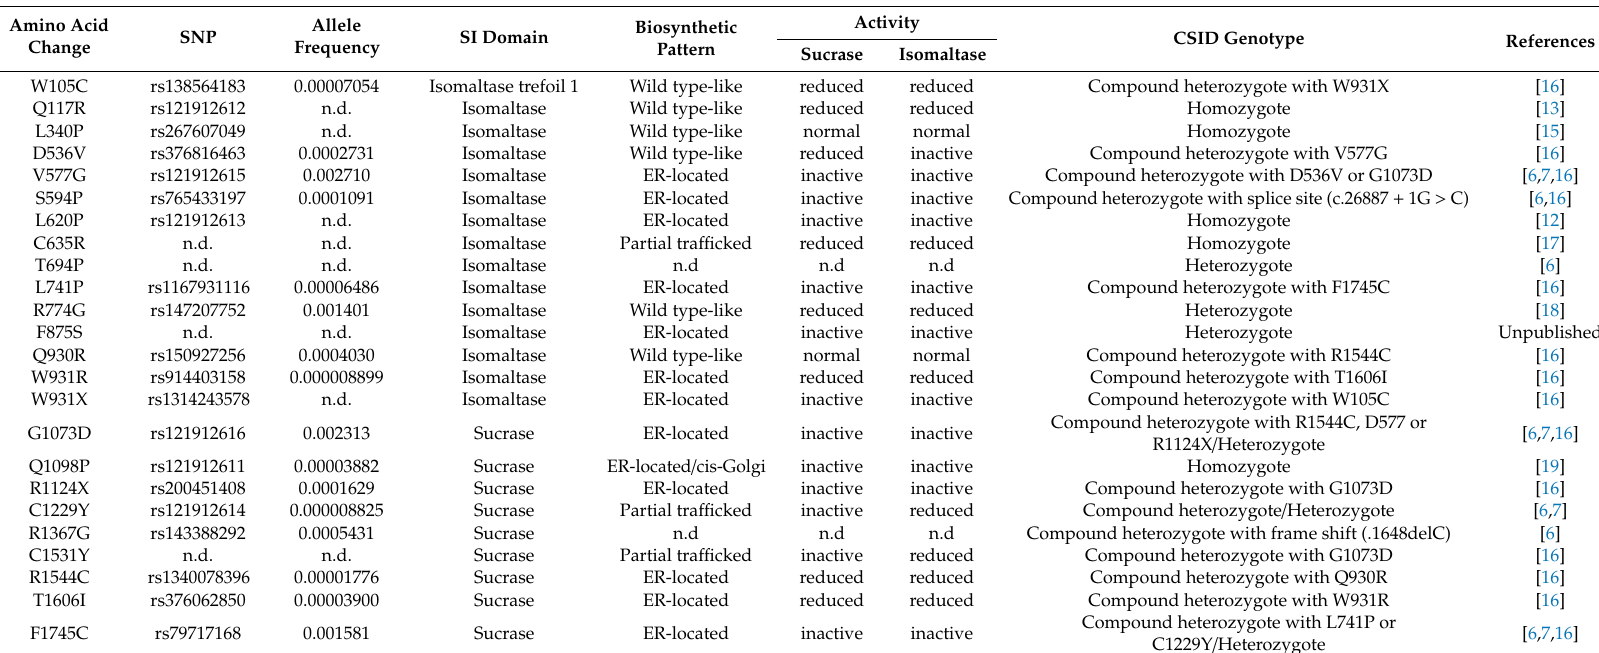
Table 2. Mutations in congenital sucrase-isomaltase deficiency (CSID), their rs number, allele frequency in the general population (non-Finnish Europeans), position in SI, biosynthetic pattern, activity and CSID